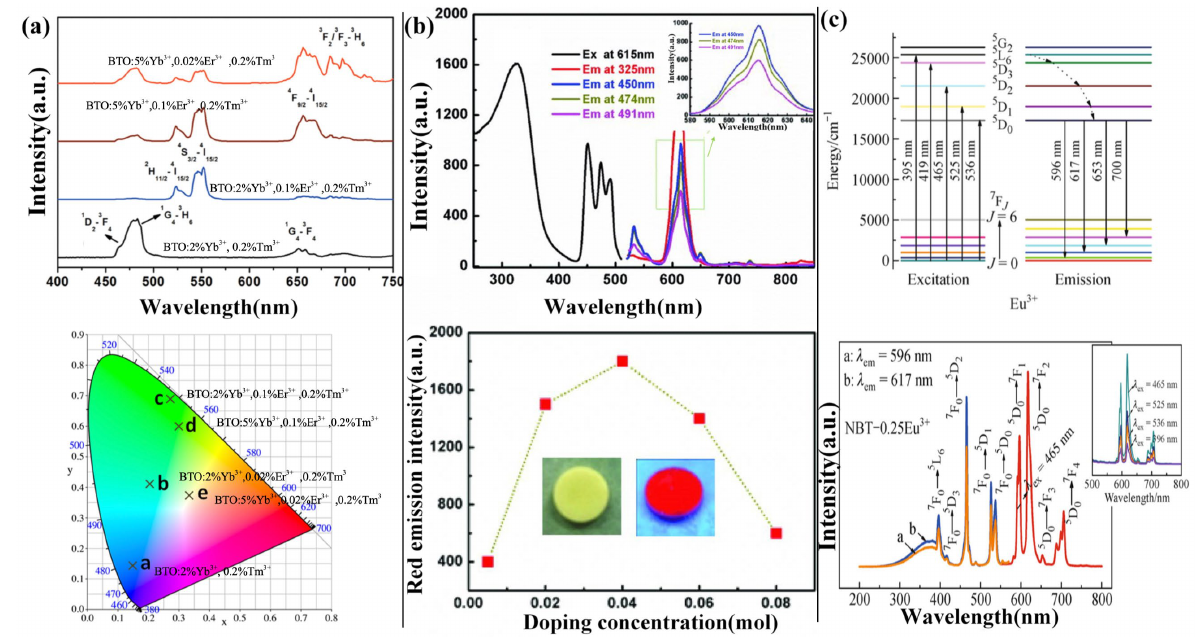
Figure 8. ( a ) UC emission spectra of BTO:Ln 3+ phosphors under 980 nm laser excitation and CIE chromaticity diagrams for BTO:Ln 3+ phosphors under 980 nm laser excitation. Reprinted with permission from [20] © 2013 AIP. ( b ) The room temperature emission (Em) and excitation (Ex) spectra of doped Pr show that the intensity is 0.04 and show the relationship between emission intensity and Pr concentration (the left inset shows the prepared target without excitation, and the right inset shows the case of excitation with a commercial ultraviolet lamp at 365 nm). Reprinted with permission from [53] © 2013 Taylor & Francis. ( c ) The possible transition relatives to excitation and emission processes of Eu 3+ ions and the PL spectra of NBT-0.25Eu 3+ sample excited by different wavelengths ( λ ex = 396 nm, 465 nm, 525 nm and 536 nm). Reprinted with permission from [54] © 2016 Springer.